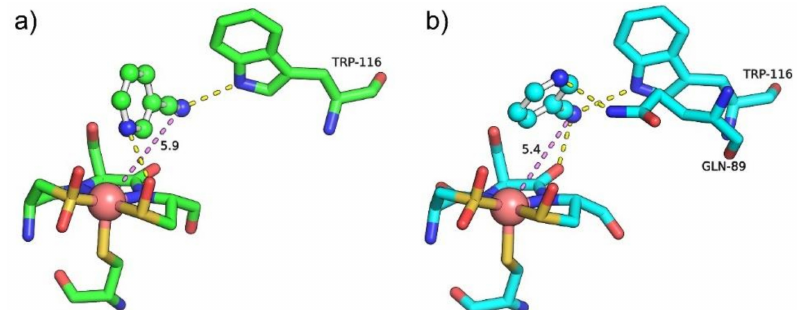
Figure 4. Molecular docking of 3-cyanopyridine into the active site of WT Pt NHase ( a ) and its M10 mutant ( b ). The active sites are presented as sticks. 3-Cyanopyridine is shown as balls and sticks. Yellow dash line represents the hydrogen bond formed between the ligand and the enzyme. Purple dash line represents the distance between the cobalt ion and the cyano nitrogen of 3-cyanopyridine.